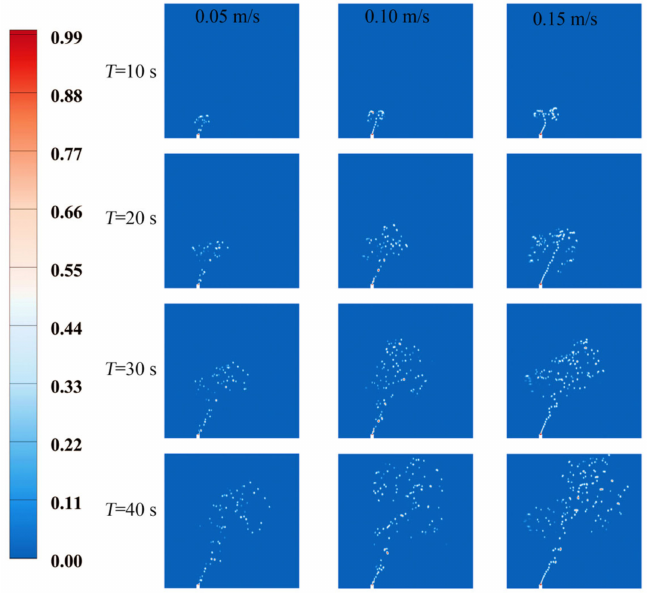
Figure 5. Effects of different current velocities on oil spill leakage and diffusion ( U P = 0.15